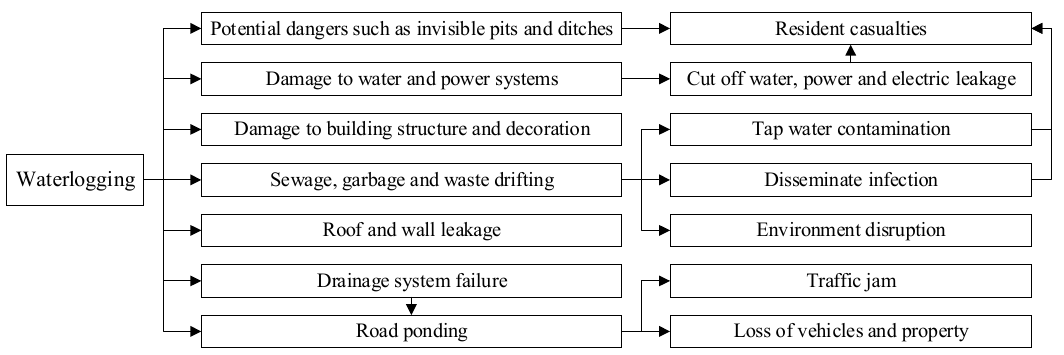
Figure 1. Community impact and chain transfer diagram of waterlogging disasters.